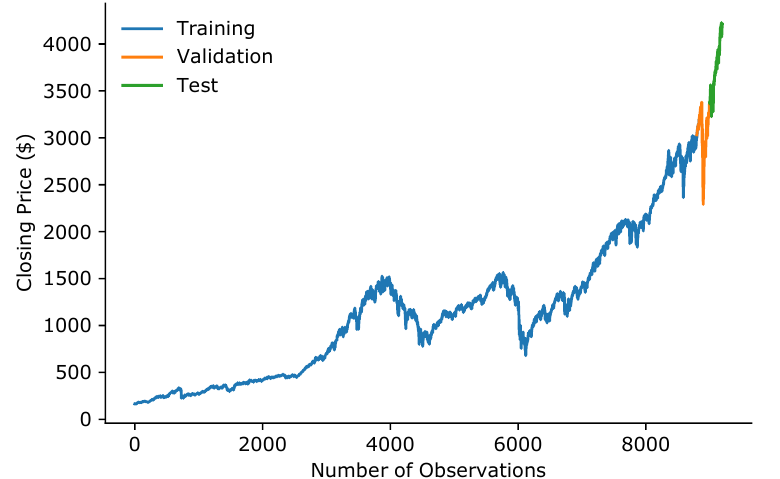
Figure 1. The closing price of S&P 500 stocks divided into training, validation, and test